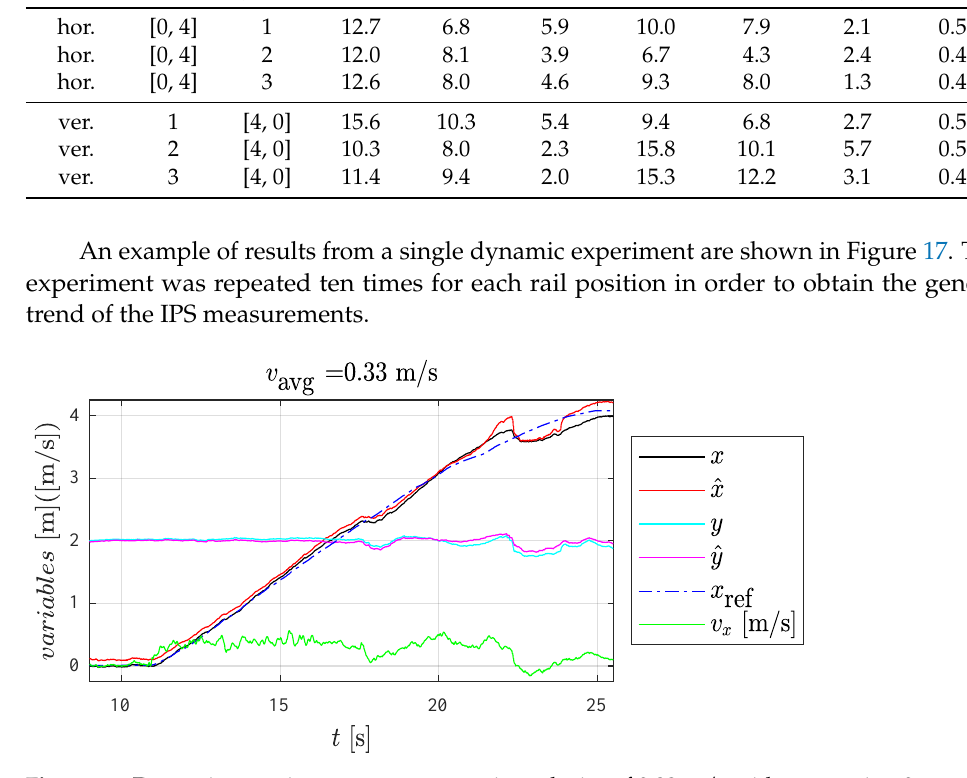
Figure 17. Dynamic experiment at average cruise velocity of 0.33 m/s with x spanning 0 m to 4 m at constant y = 2 m, where ( x , y ): position estimate with EKF-only; ( ˆ x , ˆ y ): debiased position; ( x ref ): actual position on rail; and ( v x ): estimated instantaneous velocity in x